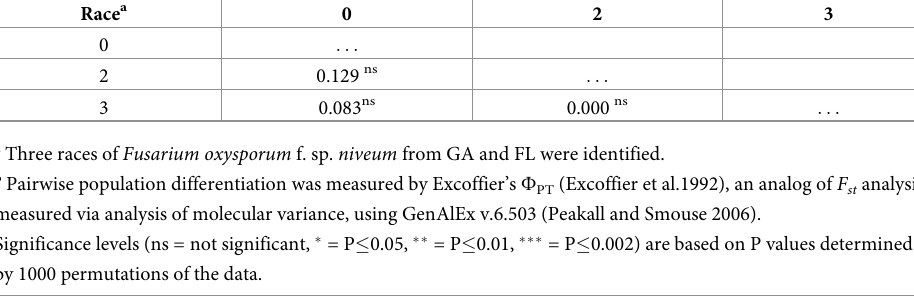
Table 6. Population structure measured by Ф PT between Fusarium oxysporum f. sp. niveum races in the southeast- ern United States. Race a